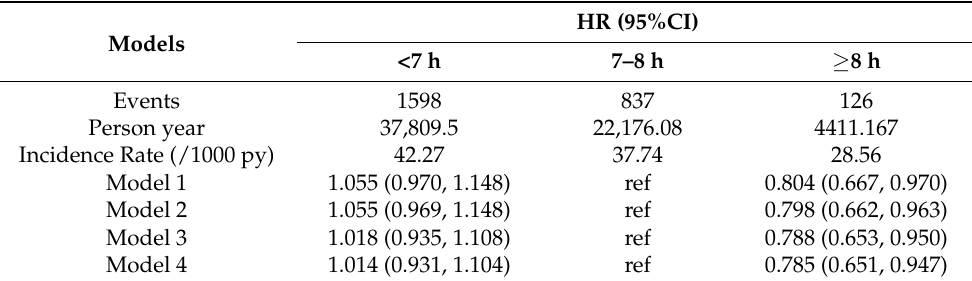
Table A1. Association of sleep duration with risk of hyperuricemia after excluding missing data ( n = 17,325, events =